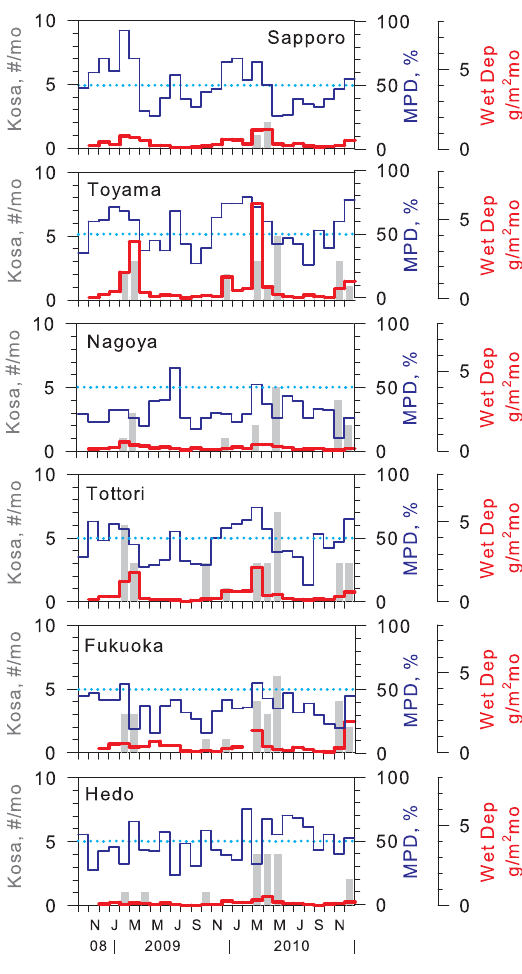
Fig. 3. Monthly numbers of aeolian dust event (Kosa) days near the sites (gray), monthly wet deposition fluxes (red), and monthly precipitation days in percent (blue). The horizontal light blue dotted line depicts 50% of monthly precipitation days.